Question: Which kind of chart has been used to present this data?
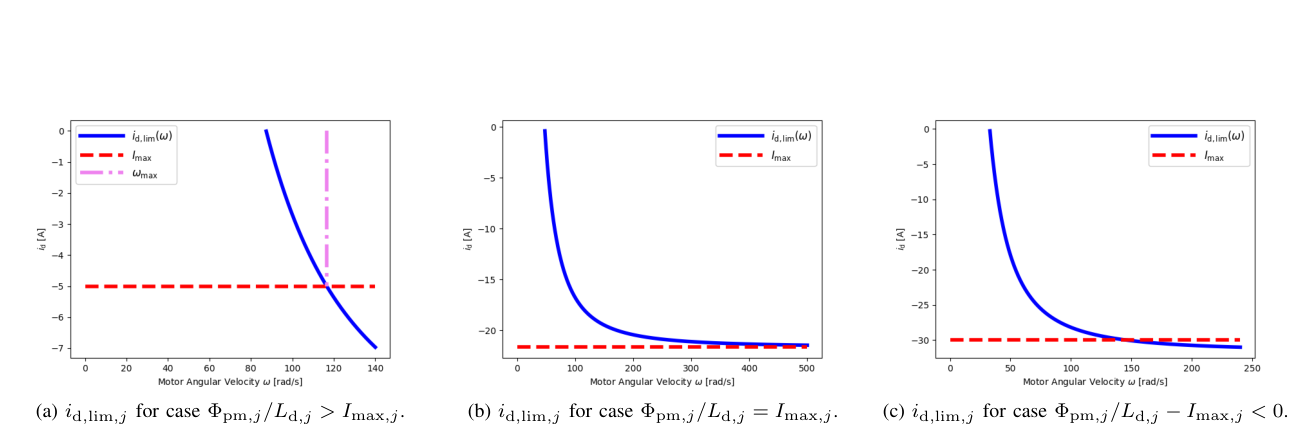
Answer: line